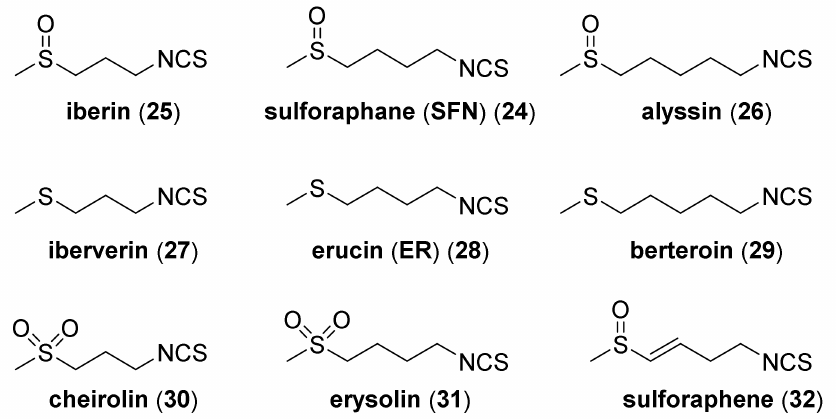
Figure 5. Structures of natural analogs of